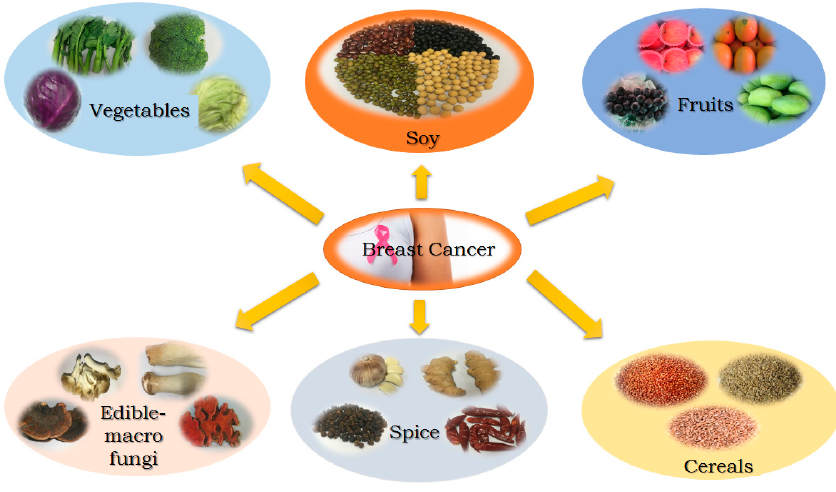
Figure 1. Dietary natural products that showed inhibitory effects on breast cancer.